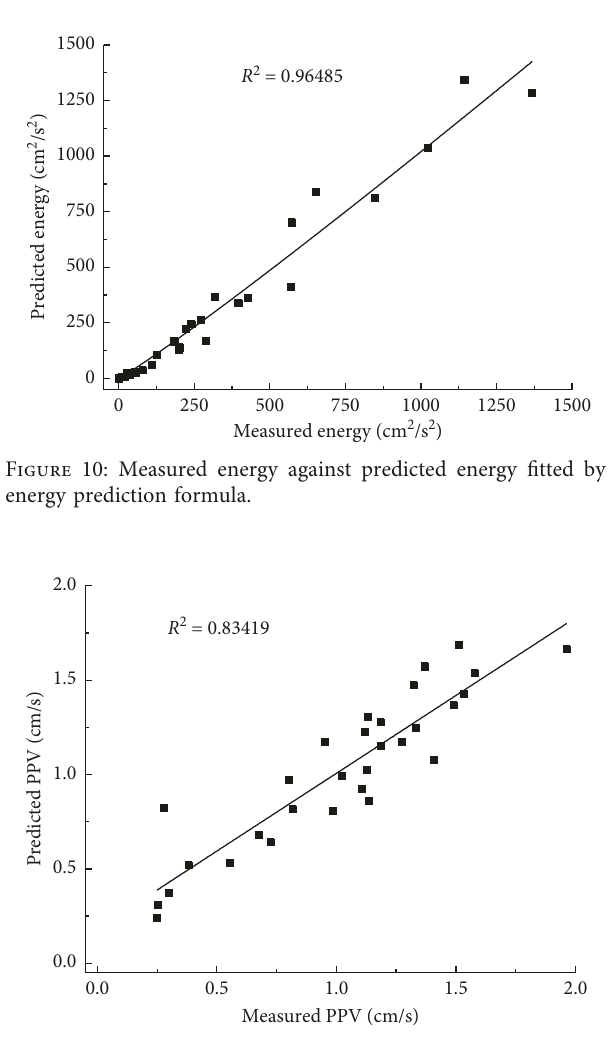
Figure 11: Measured PPVs against predicted PPVs fitted by USBM.